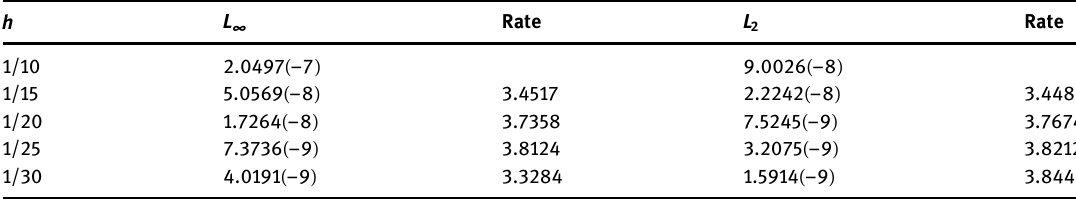
Table 12: L 2 , L ∞ errors when = τ h 4 and = T 0.001 by the HOC - LOD scheme at variable h for Example 5